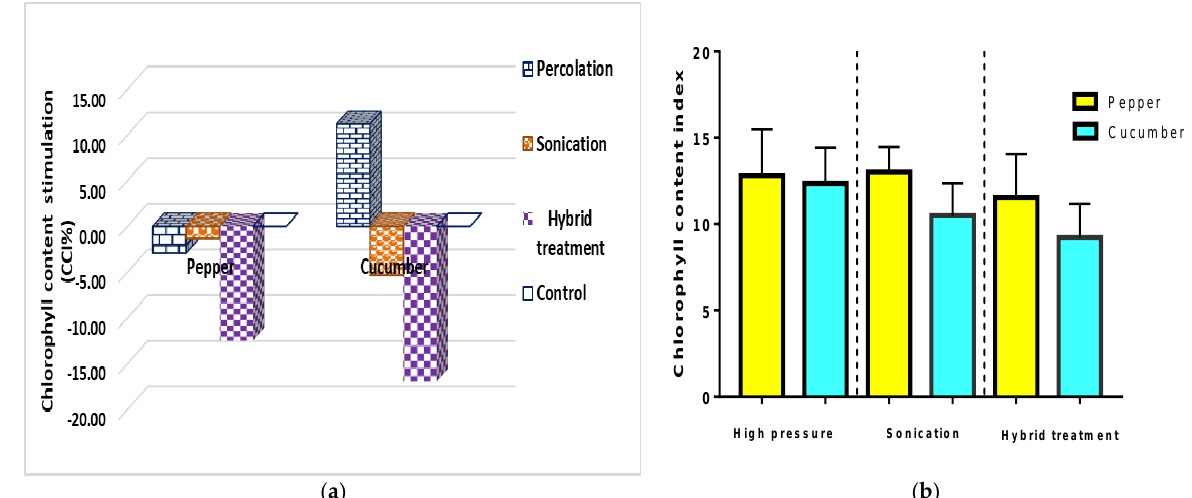
Figure 14. The influence of the obtained solutions as a biofertilizer, analyzed according to the chlo- rophyll content of the leaves: ( a ) chlorophyll content index and ( b ) statistical evaluation.